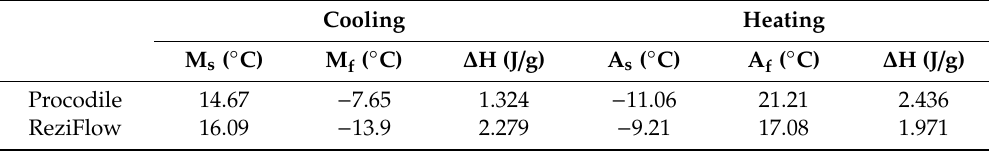
Table 3. Average phase transformation temperature and enthalpy changes ( ∆ H) of the tested